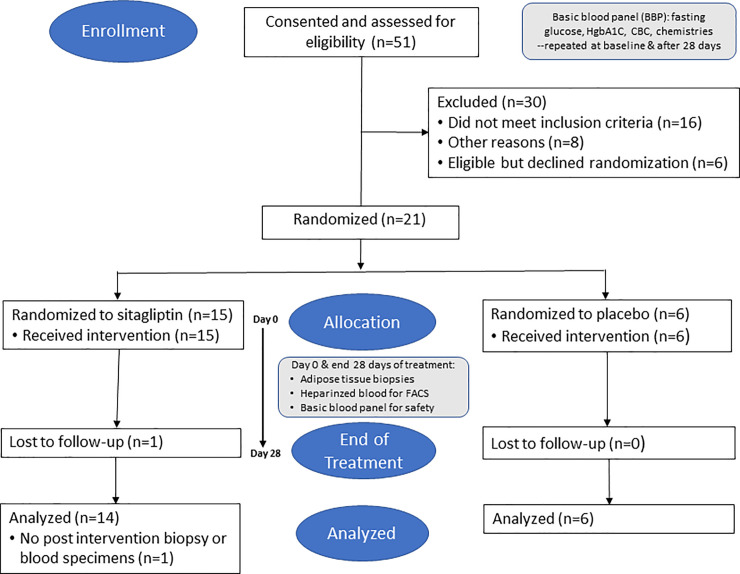
Study flow chart.